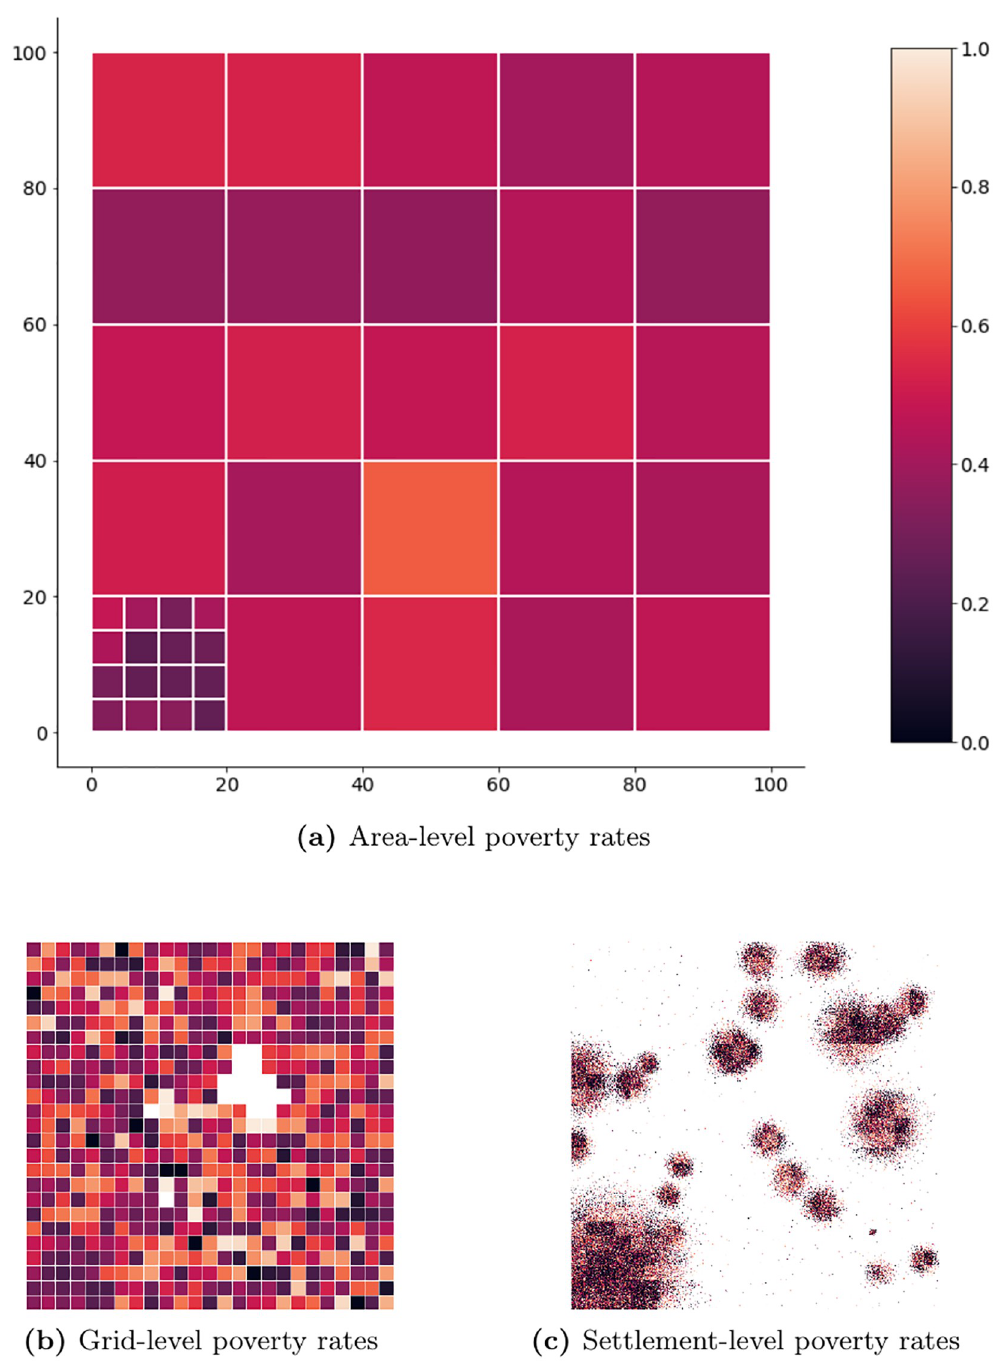
Fig 4. Simulation setup—True poverty